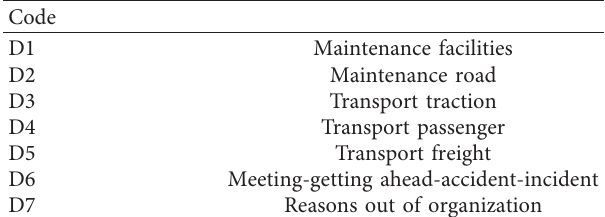
Table 3: Database of the